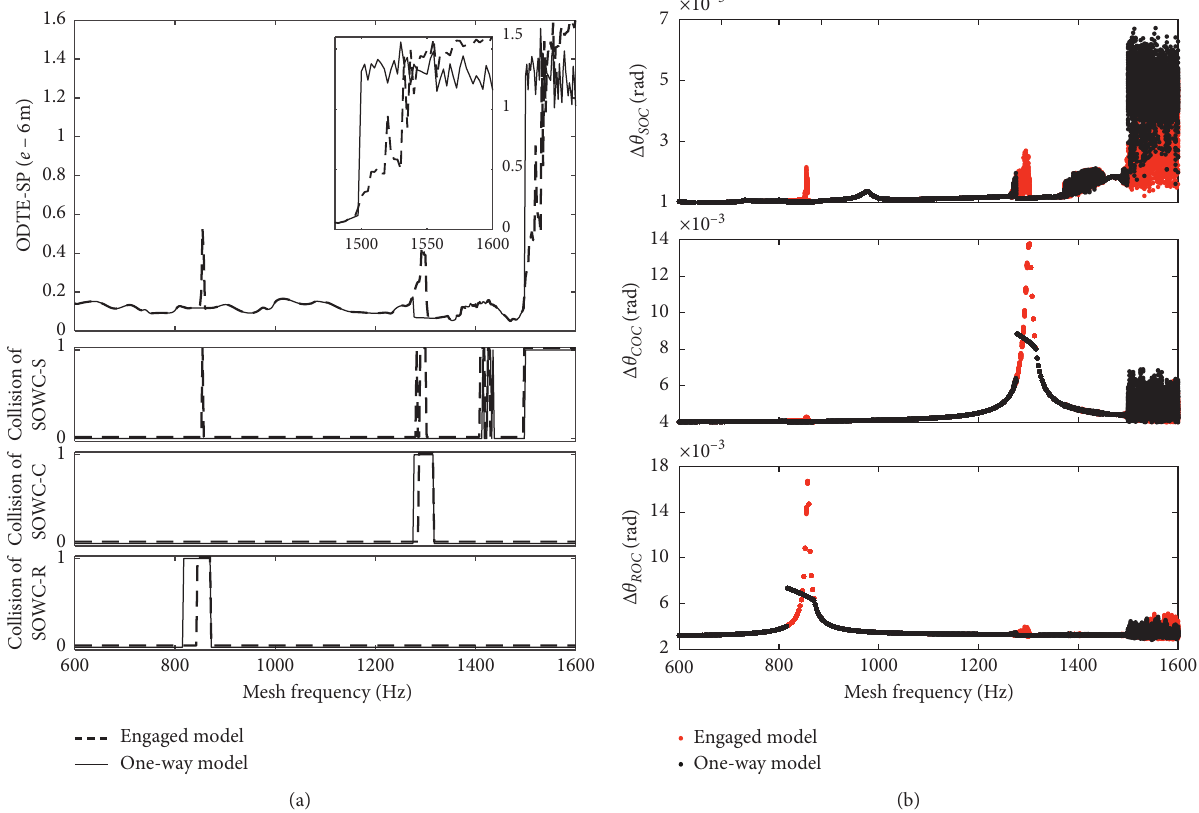
Figure 6: Comparisons of the engaged model and the one-way model. (a) Vibration characteristics of SP and collision status of SOWCs. (b) Bifurcation diagrams of each SOWC.